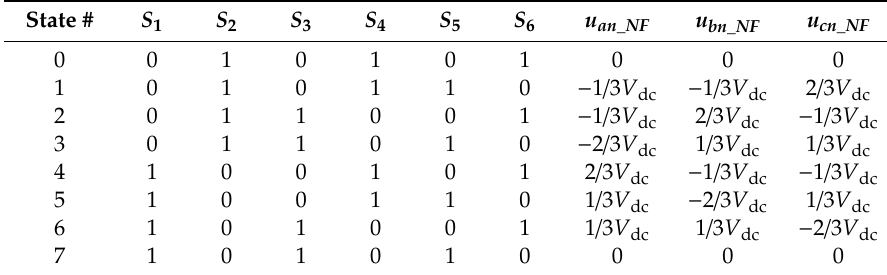
Table 2. The relationship between switching states and phase voltages under healthy conditions.